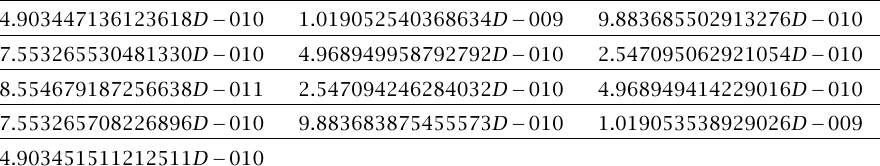
Table 3.12 . The errors with n = 13 , l = 0 . 25 on γ 0